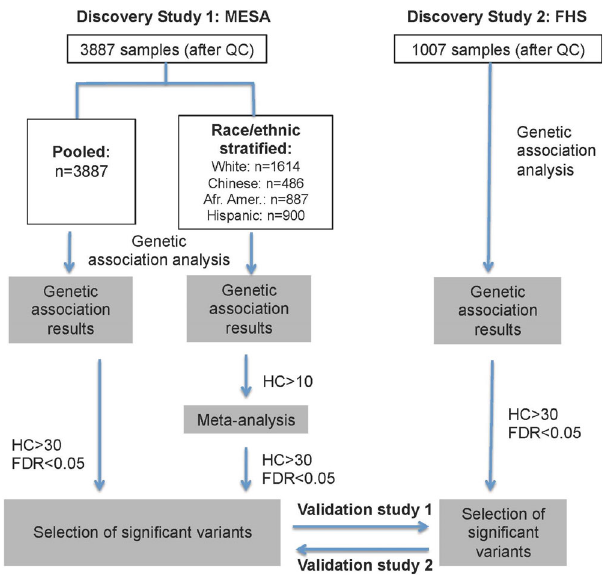
Fig. 2 Study design for discovery/validation of genetic association analysis of LAG3 protein levels in MESA and FHS. Abbreviations: Afr. Amer. = African American; HC = heterozygosity count; FDR = False discovery